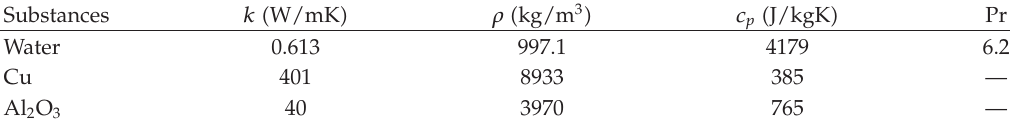
Table 1: Thermophysical properties of nanoparticules and base